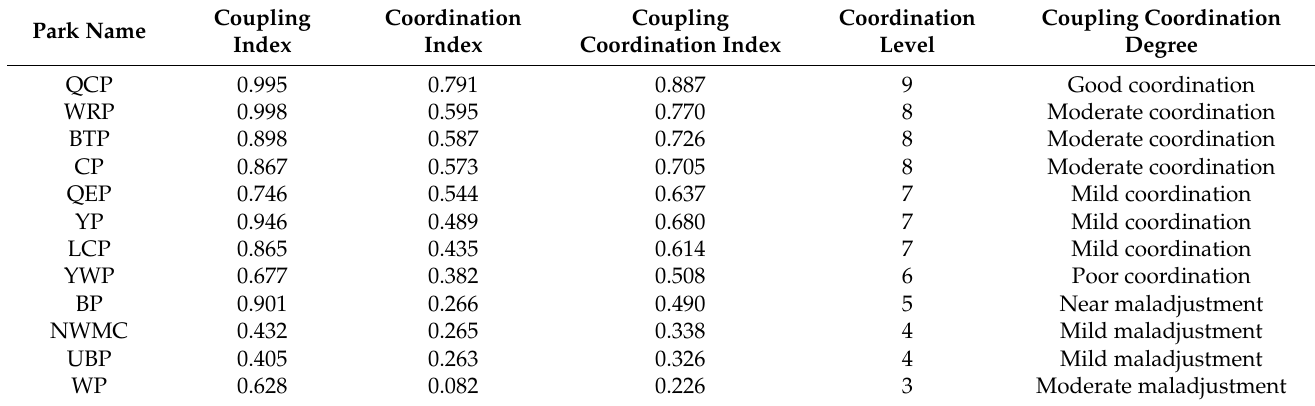
Table 9. Spatial–psychological–behavioral dimension coupling coordination degree.